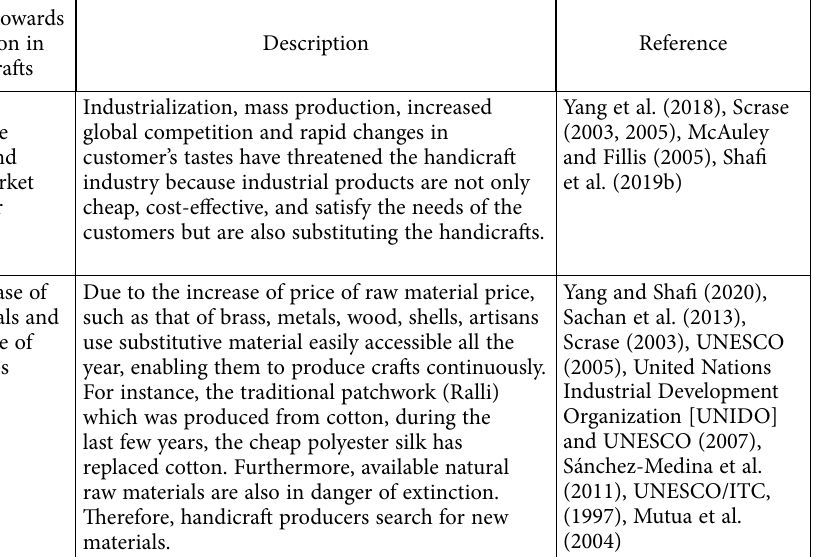
Table 1. Theoretical